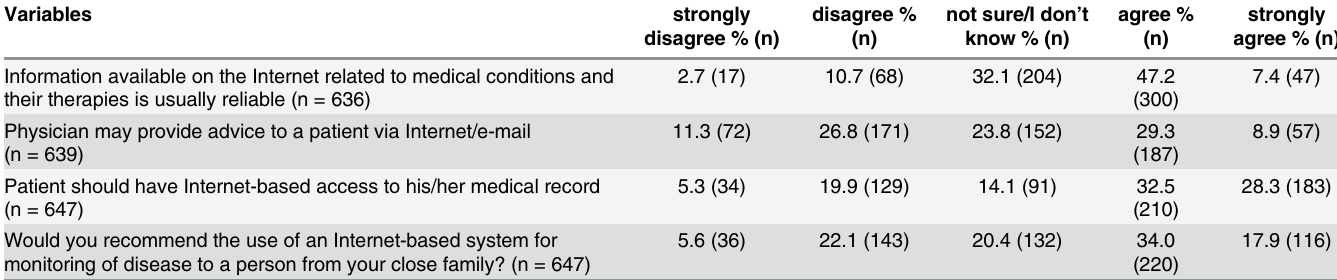
Table 3. Distribution of responses to key items from the survey used for development of outcome variables in the logistic regression models.